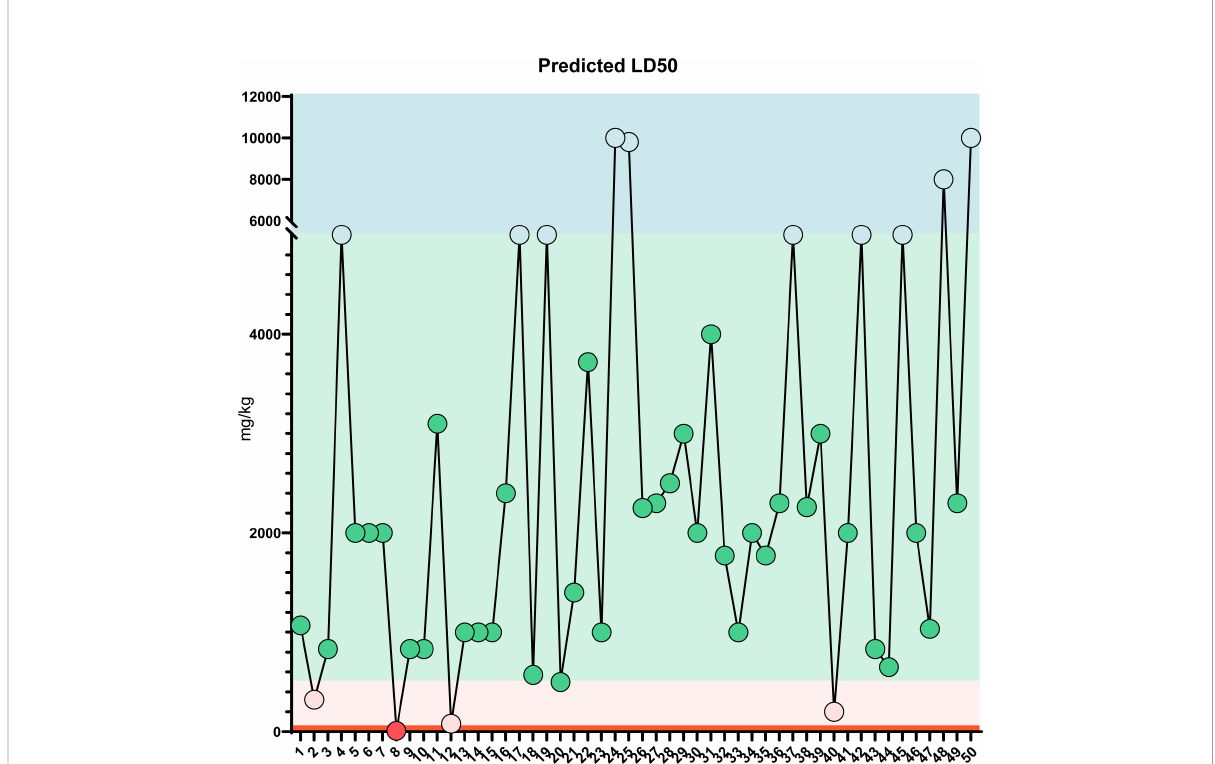
FIGURE 8 LD50 prediction: Predicted LD50 toxicity for the top 50 compounds of MQEF. The horizontal coordinates, from 1 to 50, are the top 50 compounds ranked according to the percentage of Modi fi ed Qing ’ E Formula aqueous decoction extracts obtained from plant metabolomics, and the vertical coordinates indicate the values of LD50 obtained by database prediction in 4 classes of mg/kg, which are distinguished by four different colors.